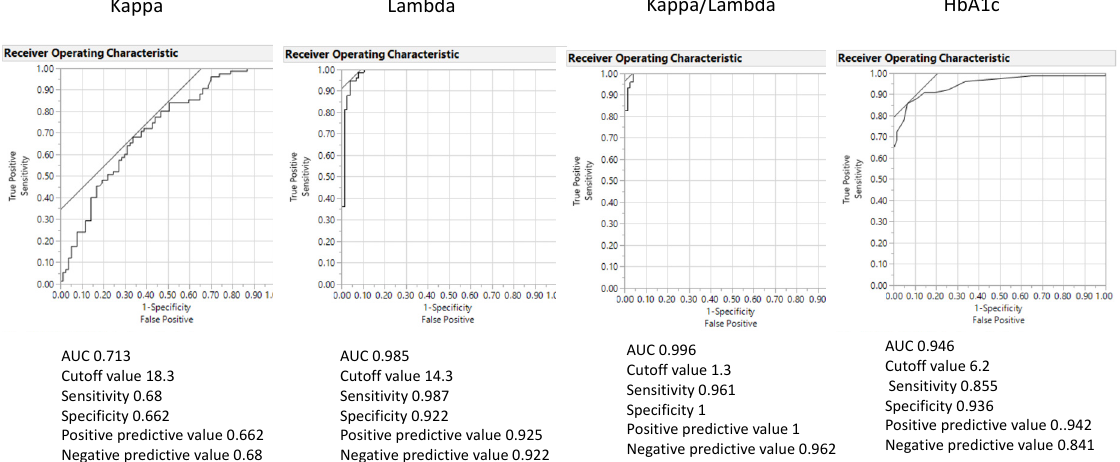
Figure 2. The area under the receiver operating curve (ROC-AUC) of the FLC κ , λ and κ / λ ratio and glycated hemoglobin (HbA1c). ROC-AUC of the FLC κ / λ ratio showed the largest compared with other FLC variables (Adapted from [13]).